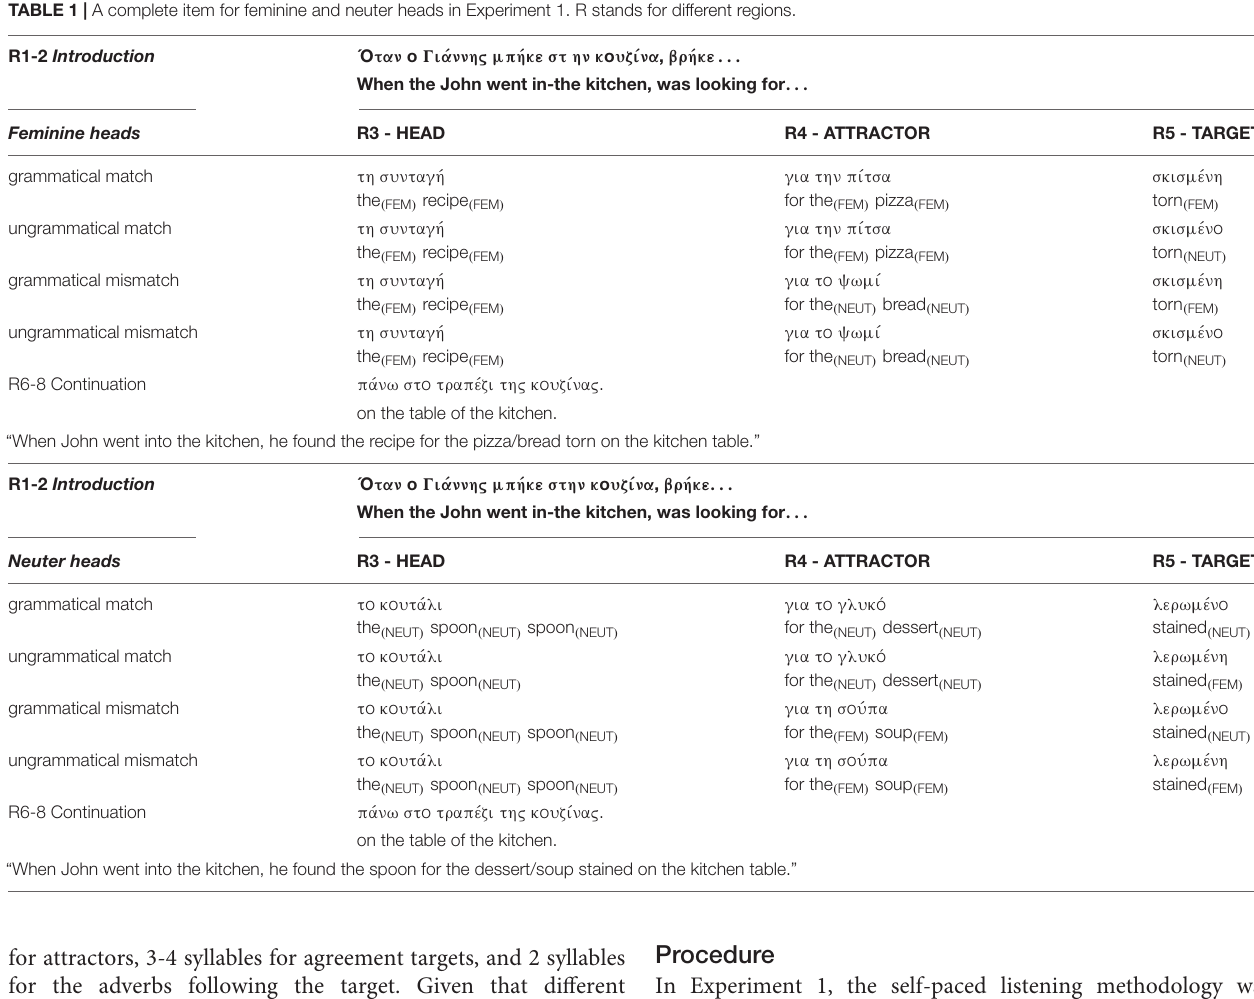
TABLE 1 | A complete item for feminine and neuter heads in Experiment 1. R stands for different